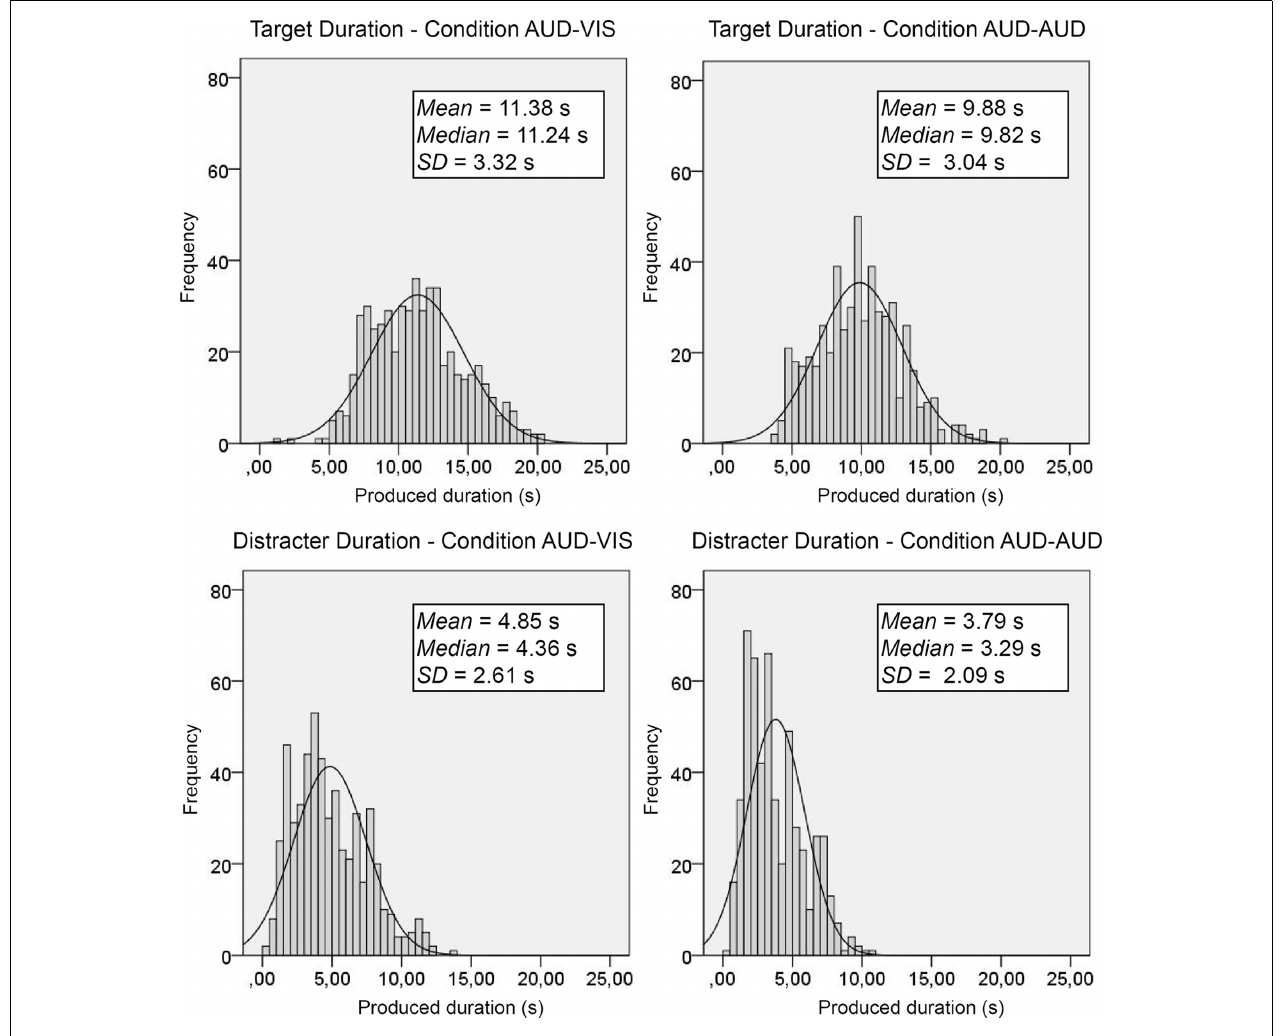
with a Gaussian curve with the same mean and the same SD as the frequency distribution. Additionally, the means, the medians, and the SDs of the frequency distributions are depicted in the